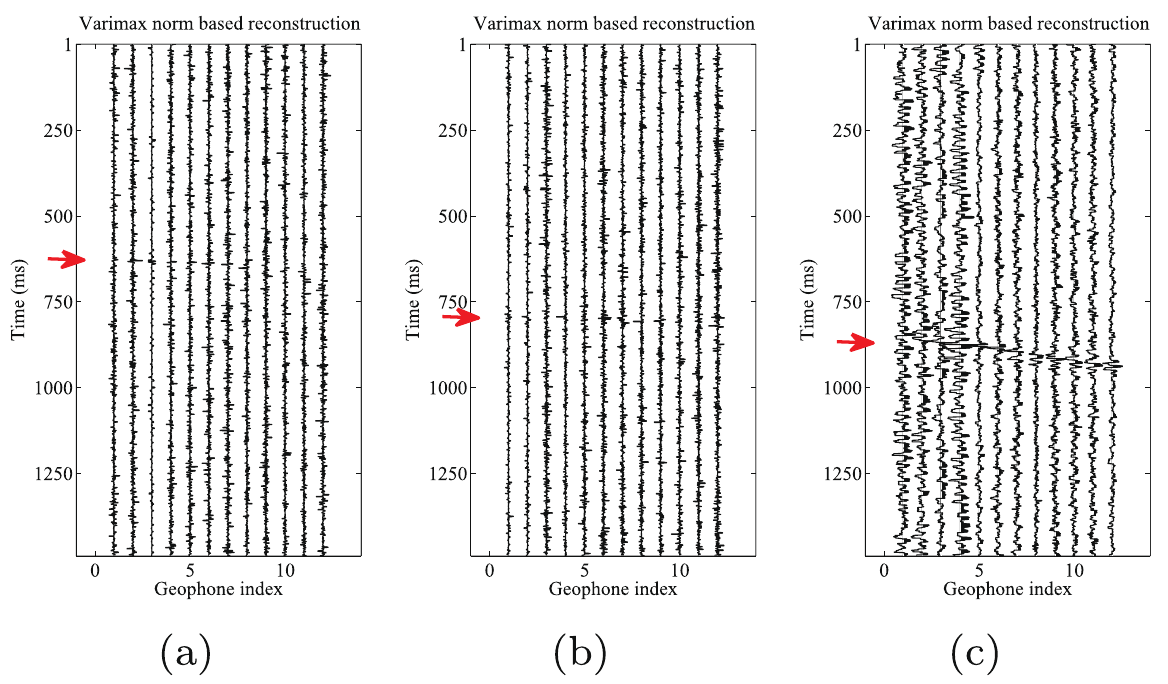
Figure 11. Varimax norm based morphological reconstruction results of ( a ) horizontal components (H1) by 2nd–4th scales components, ( b ) horizontal components (H2) by 2nd–4th scales components, and ( c ) vertical component (V) by 2nd–5th scales